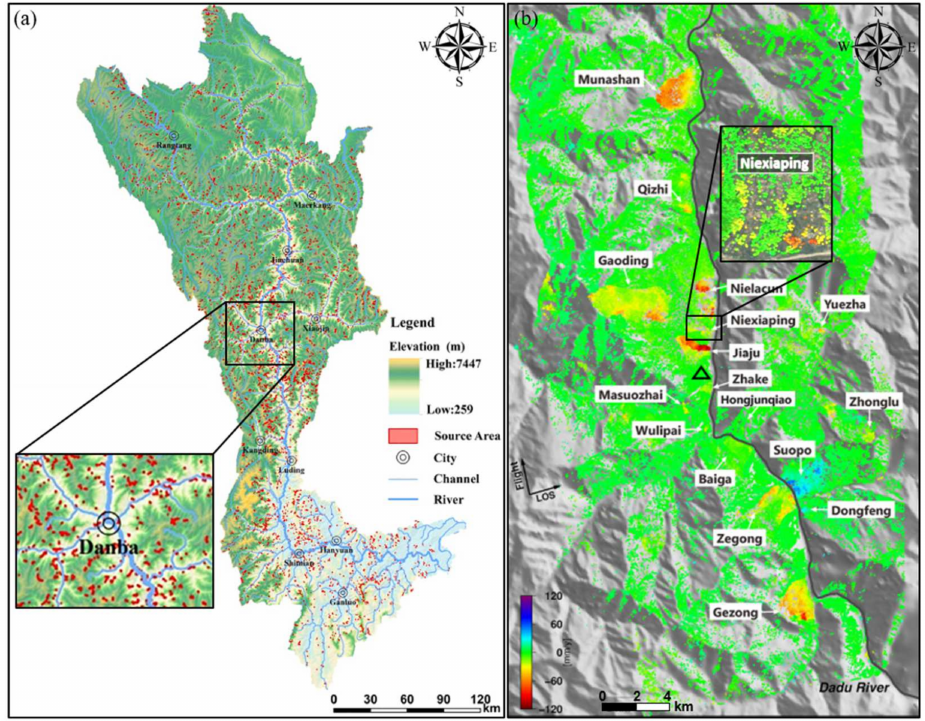
Figure 12. Landslide identification results obtained in previous studies: ( a ) Landslide source areas in Dadu River Basin (modified from [49]); ( b ) InSAR-derived LOS deformation rate maps for the upper reach of the Dadu River Basin (modified from [46]) (note: white boxes contain the names of the detected